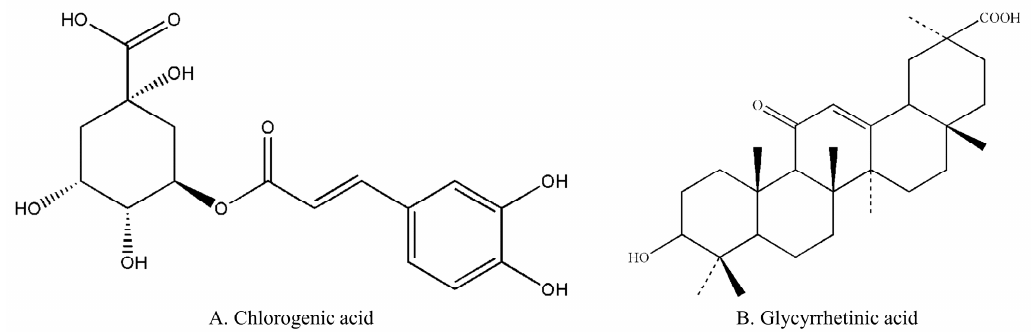
Figure 1. Chemical structures of chlorogenic acid ( A ) and glycyrrhetinic acid ( B ).